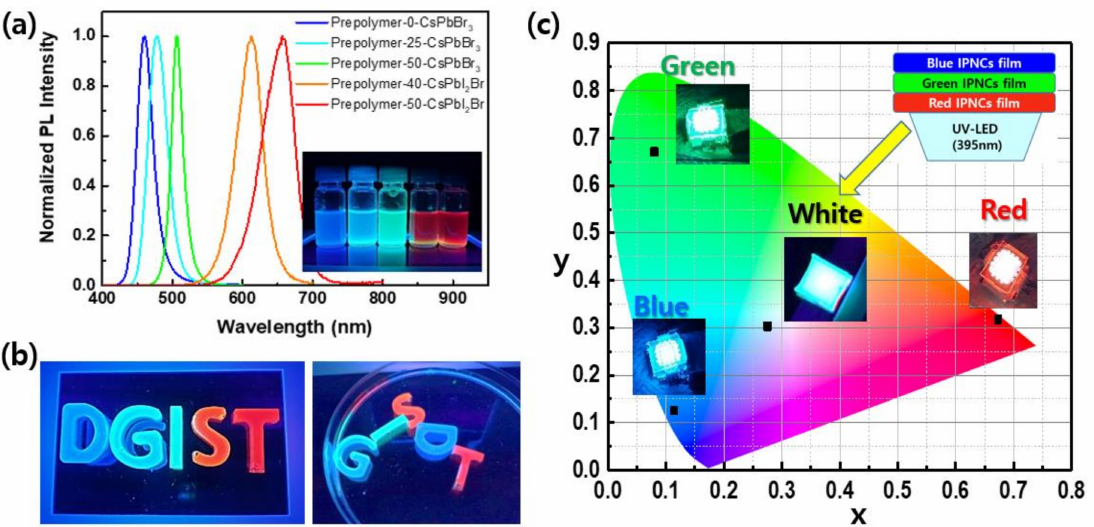
Figure 6. ( a ) Five different emission colors of the as-prepared IPeNC–prepolymer solutions and their PL spectra. ( b ) PL-emitting images of the prepared “DGIST” letters in ambient air (left) and in a water bath (right). ( c ) PL-emitting images of the color conversion films of red, green, blue, and white using a 395-nm UV light-emitting diode (LED), and their CIE color coordinates. The inset represents the configuration of the white LED